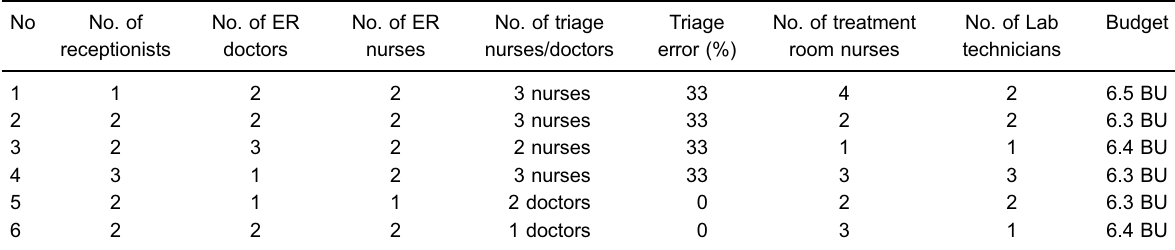
Table 2. Characteristics of selected